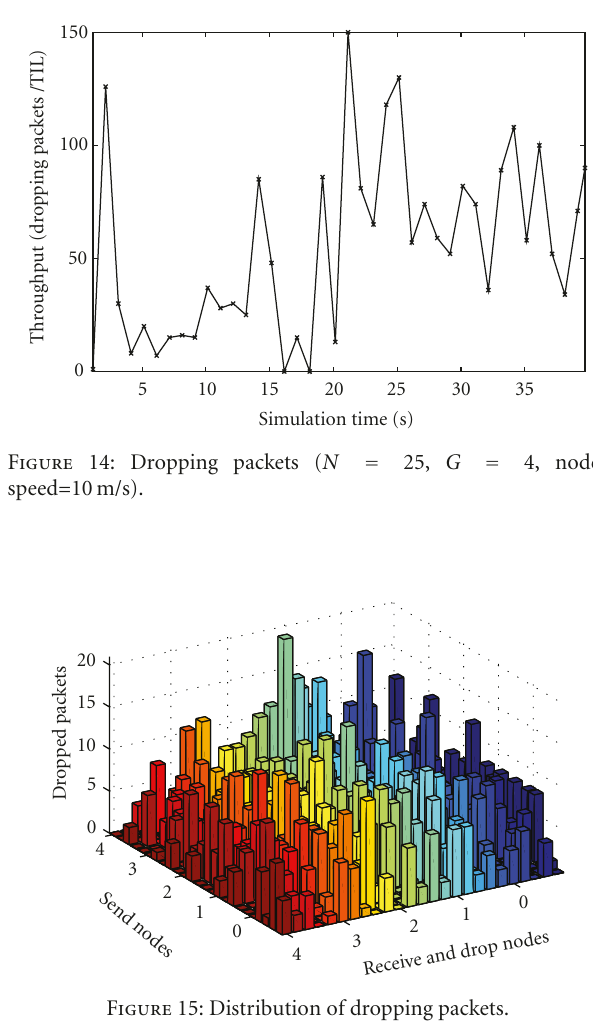
Figure 15: Distribution of dropping